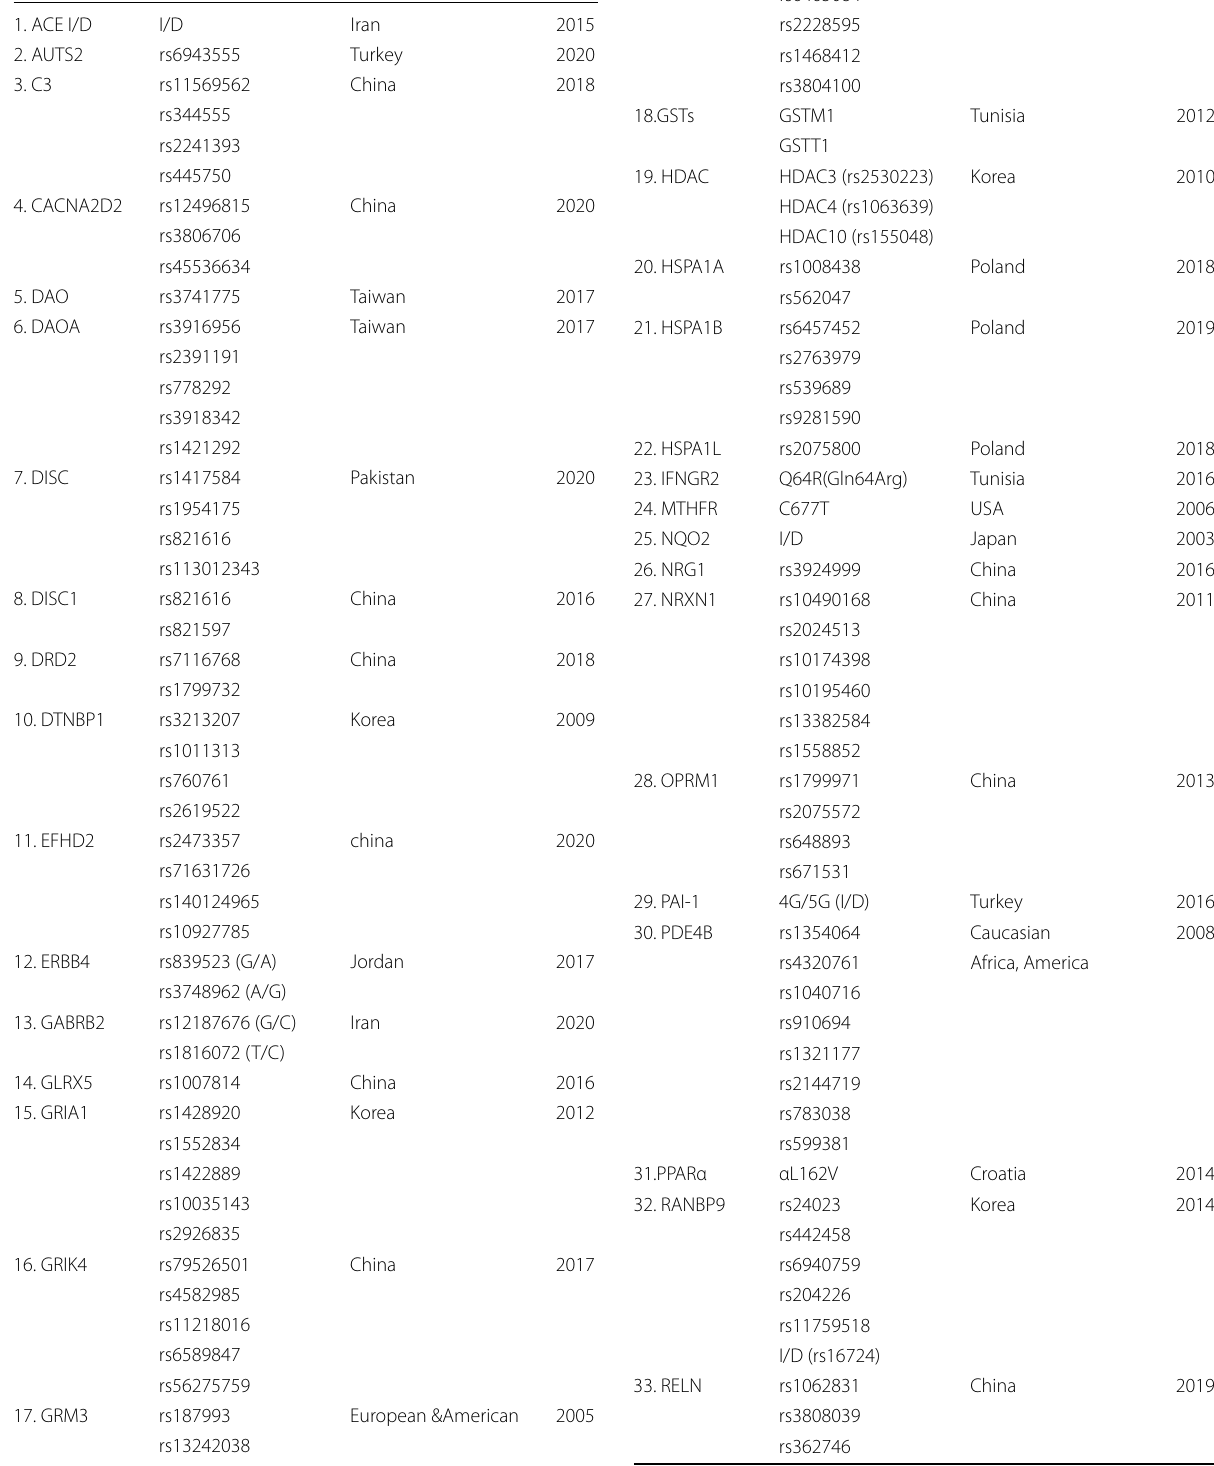
Table 1 The different genes investigated within the selected